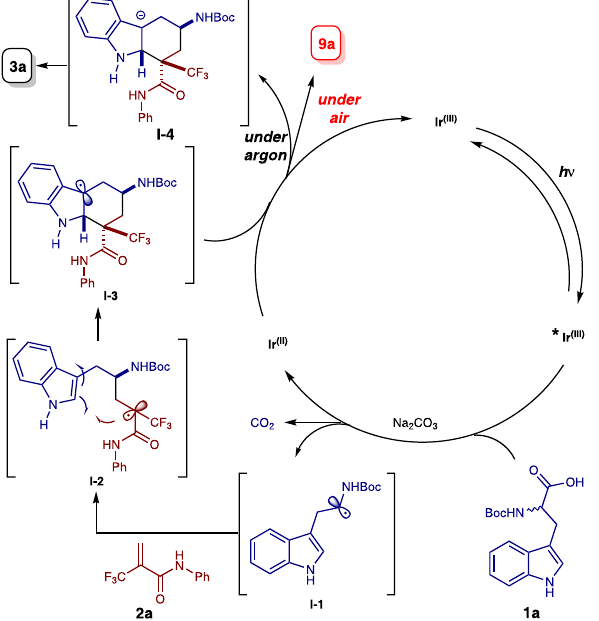
Fig. 7 A plausible reaction pathway. A plausible reaction pathway for the formation of products 3a and 9a was proposed.